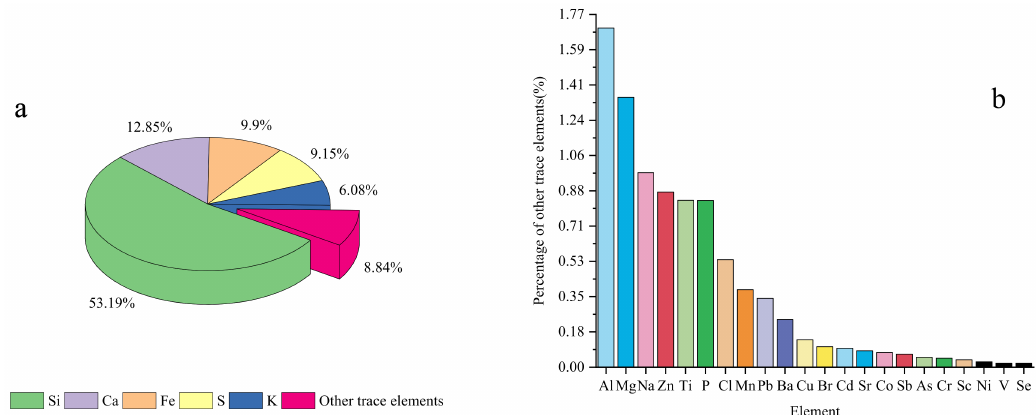
Figure 6. Proportion of Si, Ca, Fe, S, K and other trace elements ( a ) and specific proportion of other trace elements ( b